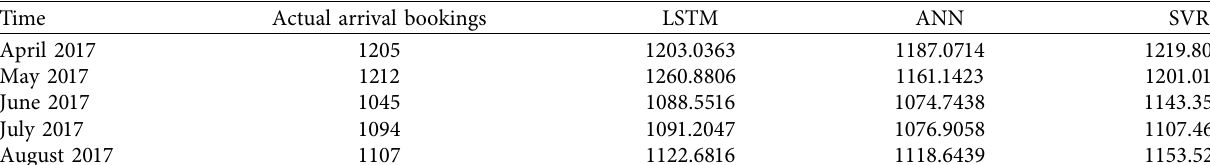
Table 4: Testing predictive results of each model.